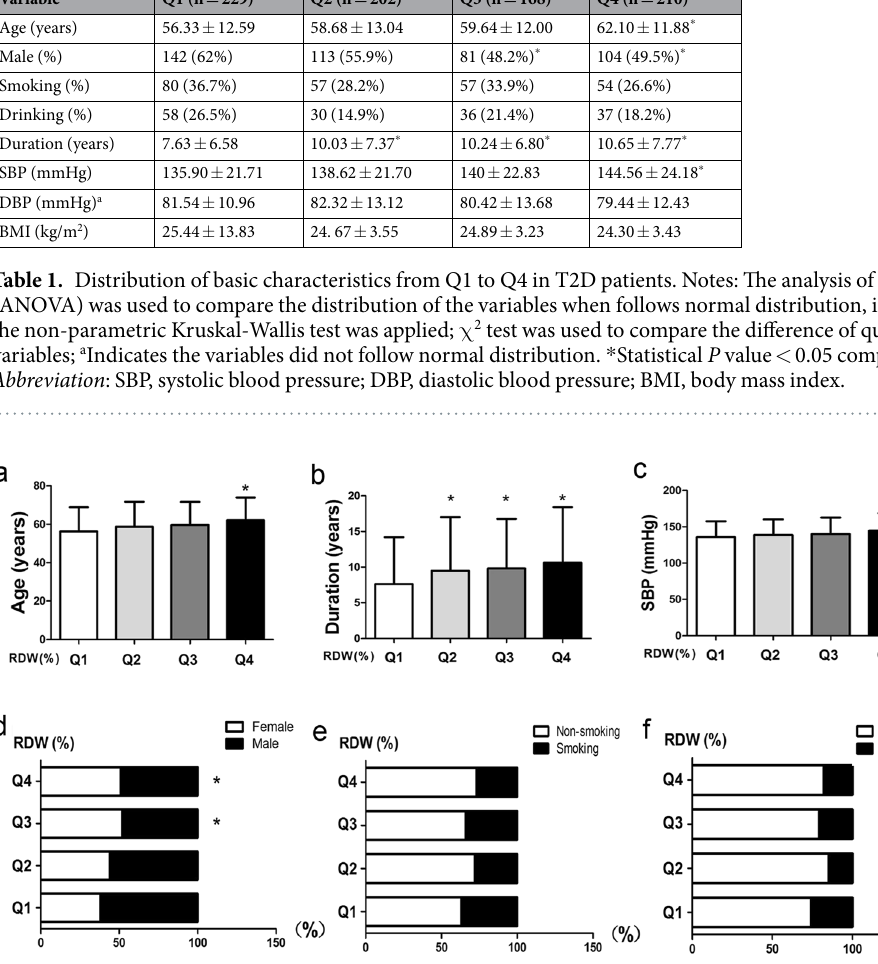
Figure 1. General characteristics of Q1 to Q4 in the T2D patients. ( a ) Distribution of age in Q1 to Q4; ( b ) Distribution of duration in Q1 to Q4; ( c ) Distribution of SBP in Q1 to Q4; ( d ) Distribution of male proportion in Q1 to Q4; ( e ) Distribution of smoking proportion in Q1 to Q4; ( f ) Distribution of drinking proportion in Q1 to Q4. * P value of less than 0.05 compared with the Q1. Abbreviation: SBP, systolic blood